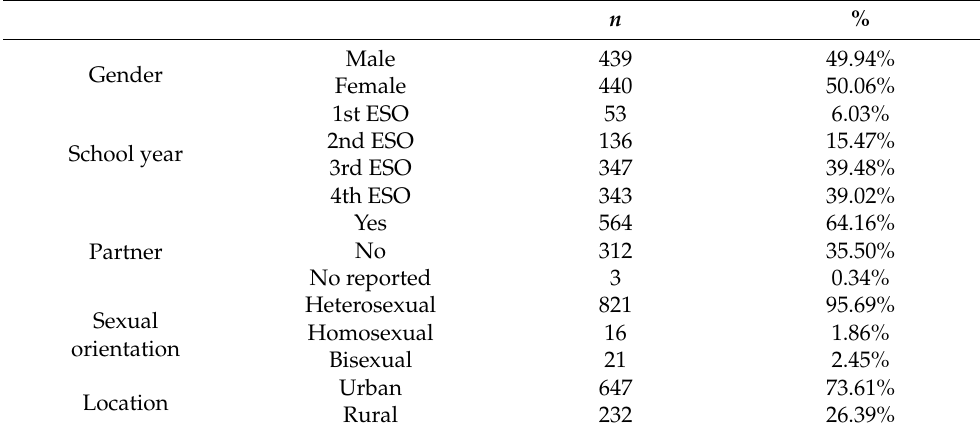
Table 1. Descriptive analysis of qualitative variables.